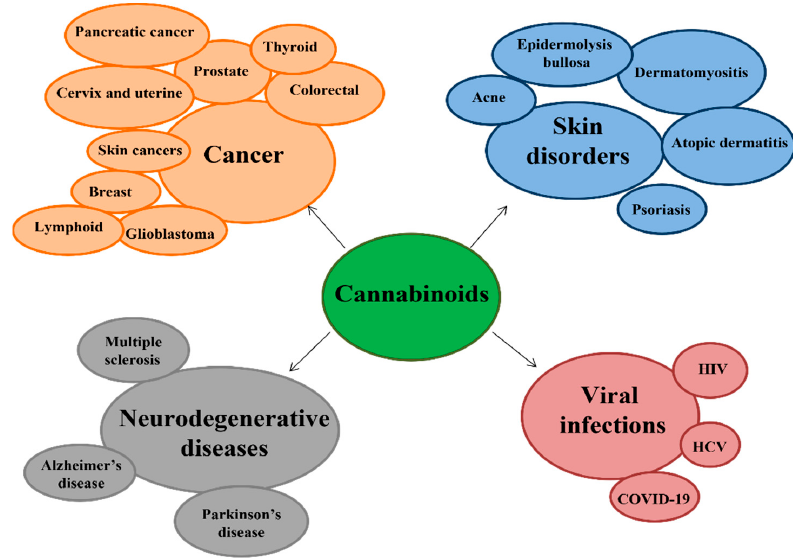
Figure 2. Diseases in which cannabinoids exhibit their therapeutic